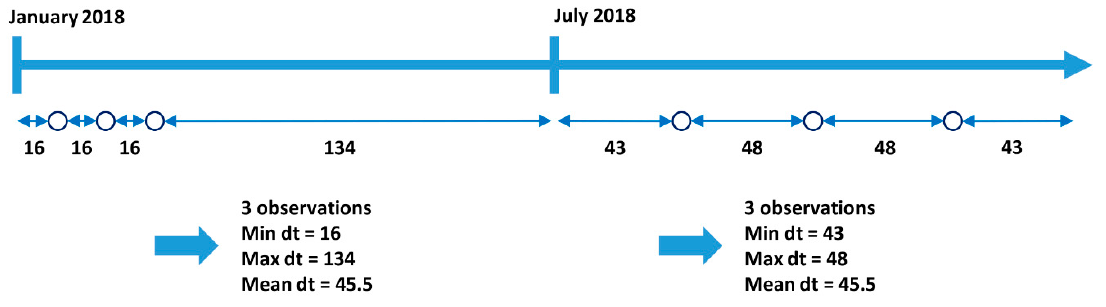
Figure 7. Processing scheme of FORCE clear sky observations (CSO).